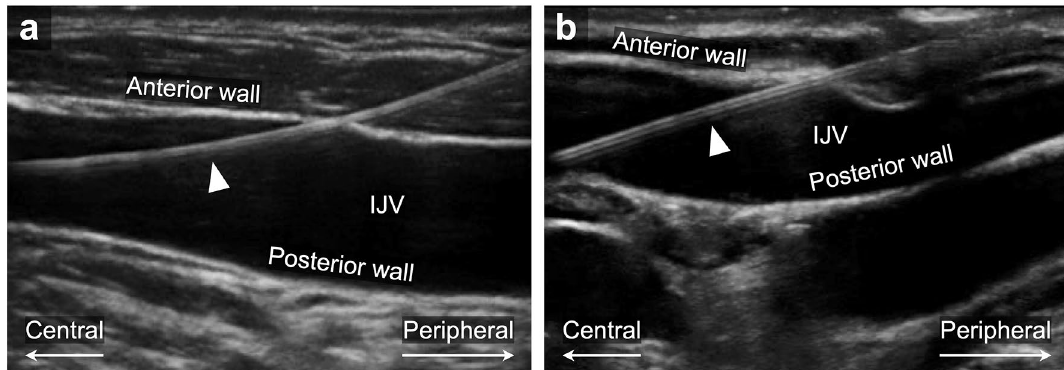
Figure 1. ( a ) Parallel guidewire image. The guidewire is traveling along the IJV parallel to it and without any changes in angle (arrowhead). ( b ) Non-parallel guidewire image. The guidewire is not traveling along the IJV parallel to it (arrowhead). IJV internal jugular